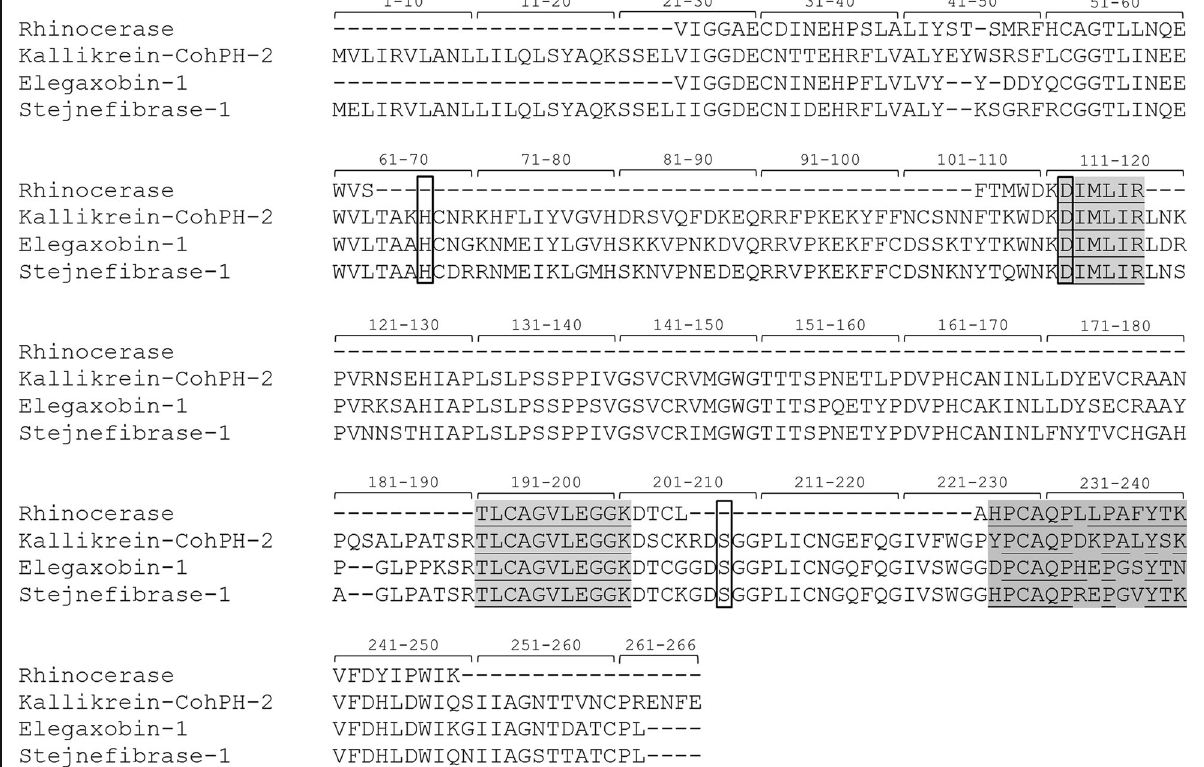
Fig. 3 Kn-Ba identification by mass spectrometry. The three Kn-Ba peptide sequences obtained by MS/MS analysis were aligned with four known serine proteases sequences available in the UniProtKB database: rhinocerase (P86497), kallikrein-CohPH-2 (JAA98009), elegaxobin-1 (P84788) and stejnefibrinase-1 (Q8AY80). The sequences identified by de novo peptide sequencing are highlighted in gray. The residues with 100% identity are underlined. Catalytic triad is in the open